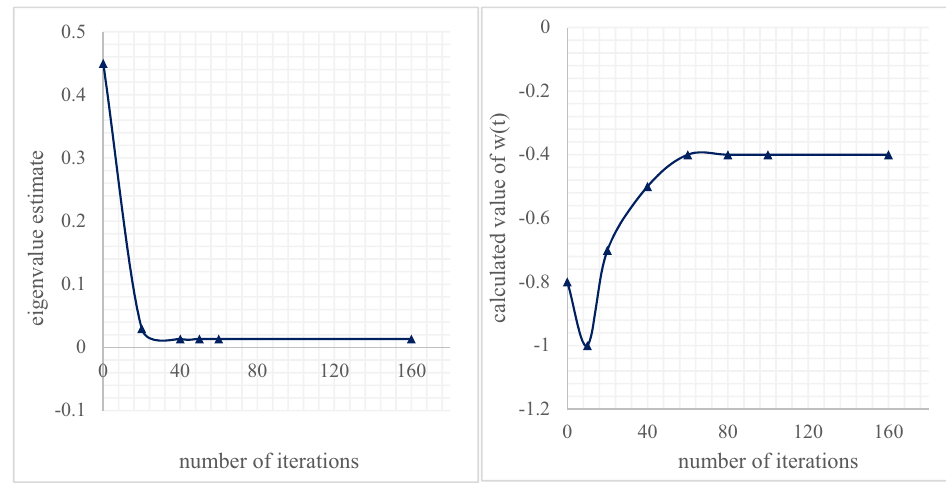
Figure 10: RNNS algorithm matrix eigenvalues and eigenvalue vector calculation